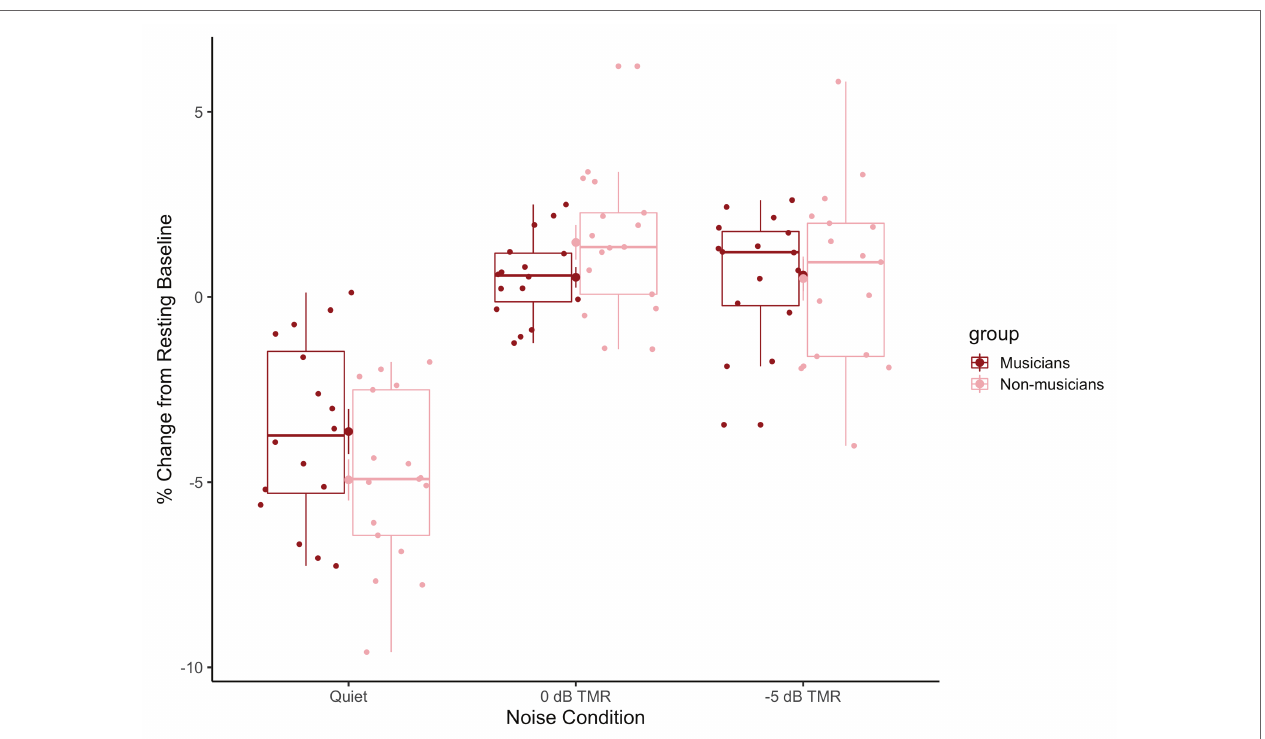
FIGURE 6 | Boxplots represent the percentage of change in the pre-target baseline relative to the resting state baseline for musicians (dark red) and non-musicians (light pink) across conditions (speech-in-quiet: left, 0 dB TMR: middle, and − 5 dB TMR: right). The horizontal line in the box represents the median values and the dots represent the individual participants’ relative change in pre-target baseline averaged across